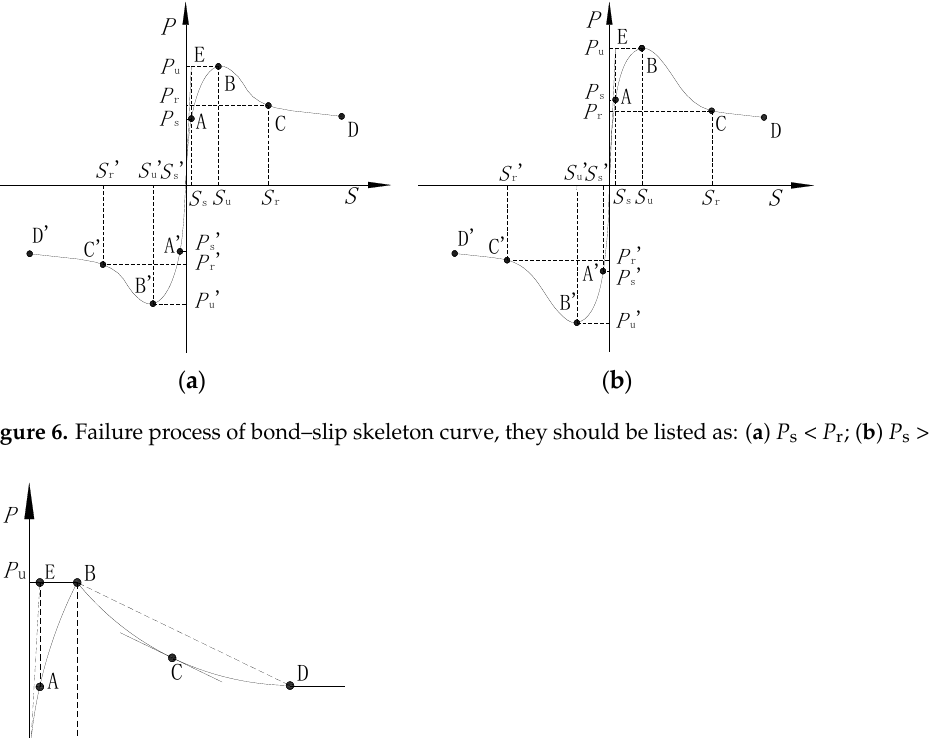
Figure 5. Typical failure modes of specimen, they should be listed as: ( a ) RCES ‐ 02; ( b ) RCES ‐ 03; ( c ) RCES ‐ 05; ( d ) RCES ‐ 08; ( e ) RCES ‐ 09; ( f ) RCES ‐ 10; ( g ) RCES ‐ 12; ( h ) RCES ‐ 13.